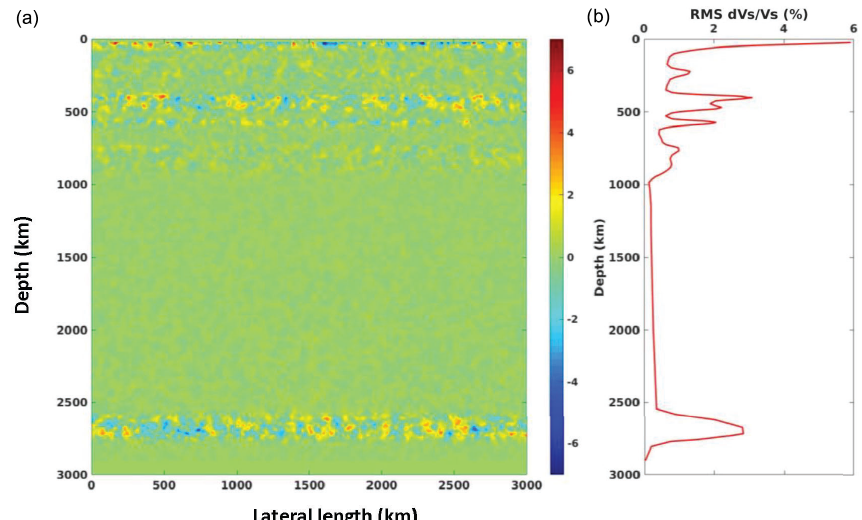
Figure 3. (b) Depth-dependent rms shear velocity perturbation profile applied in MODEL 4 vs. perturbation values from crust to 1000km depth extracted from the stochastic tomography result of Cormier et al. (2019). Compared to MODEL 3, an additional peak is added near the core mantle boundary to incorporate the increased lower mantle associated with the post-perovskite phase change (Stixrude and Lithgow- Bertelloni, 2012). (a) 2-D representation of the same depth-dependent profile.